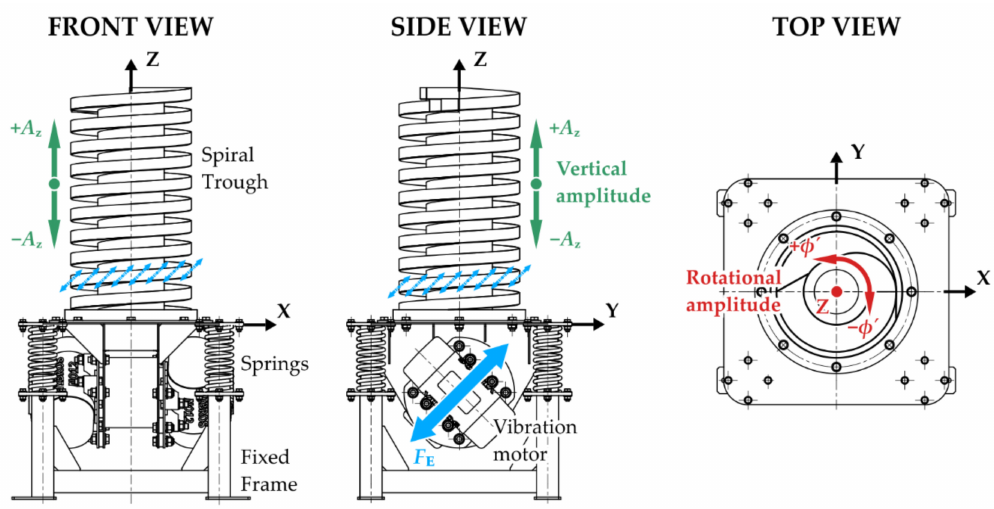
Figure 3. Schematic drawing of the placement of a pair of vibromotors and the purpose of the oscillation of individual movements.